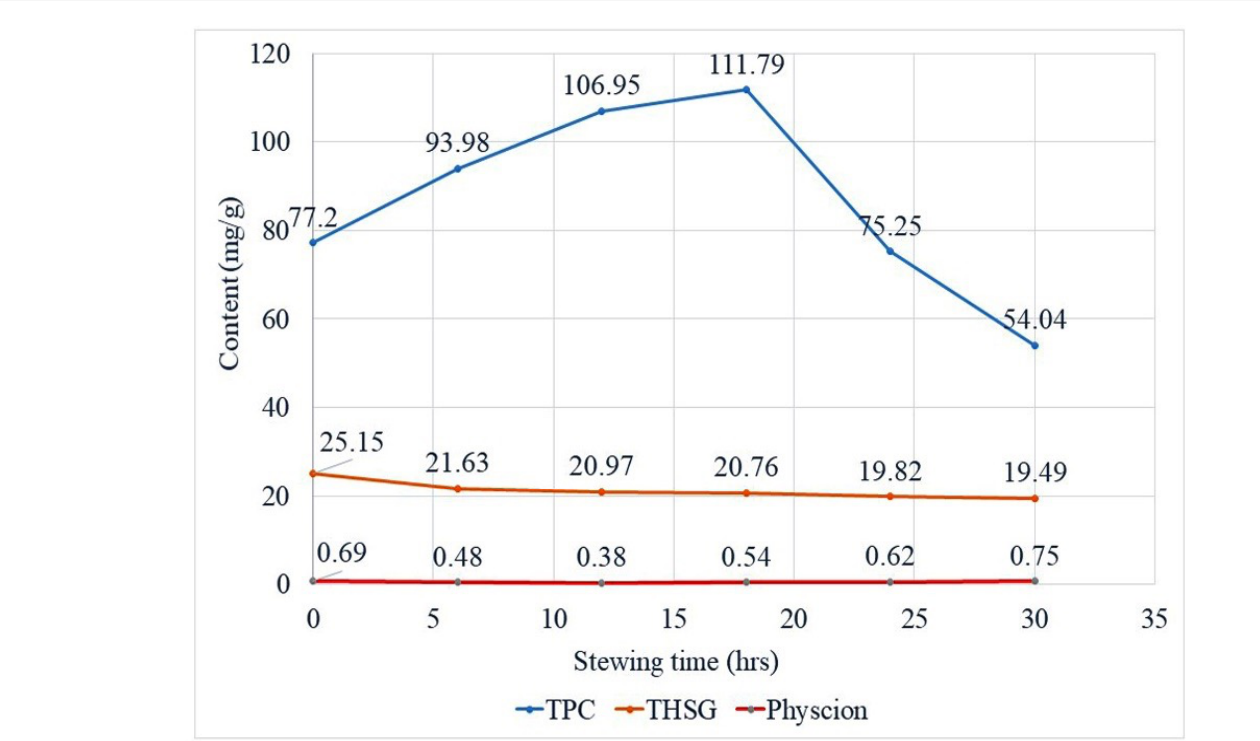
FIGURE 4 - Effect of stewing time on TP, THSG, and physcion contents in the processed FMT